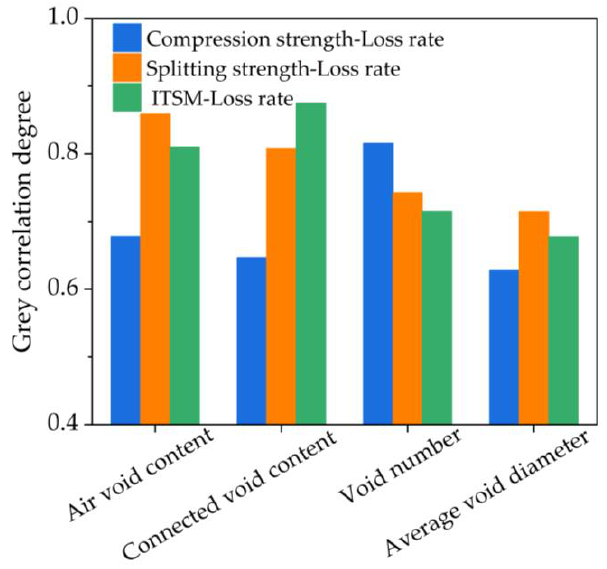
Figure 11. Correlation between mechanical damage and meso characteristics of asphalt mixture.